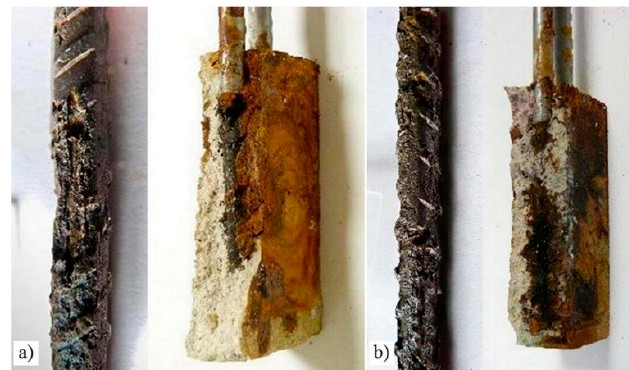
Figure 8. Corrosion products in the test specimens without ( a ) and with LFS ( b ), with 2% chloride ions by weight of cement.